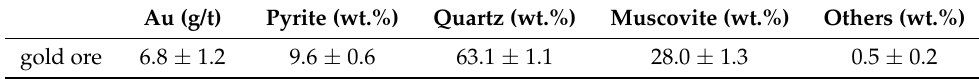
Figure 4. Mineralogical properties of gold ore: ( a ) XRD patterns and ( b ) photographs of gold ore (Py: pyrite, Qtz: quartz, Mu: muscovite). Table 2. Mineral composition of gold ore.